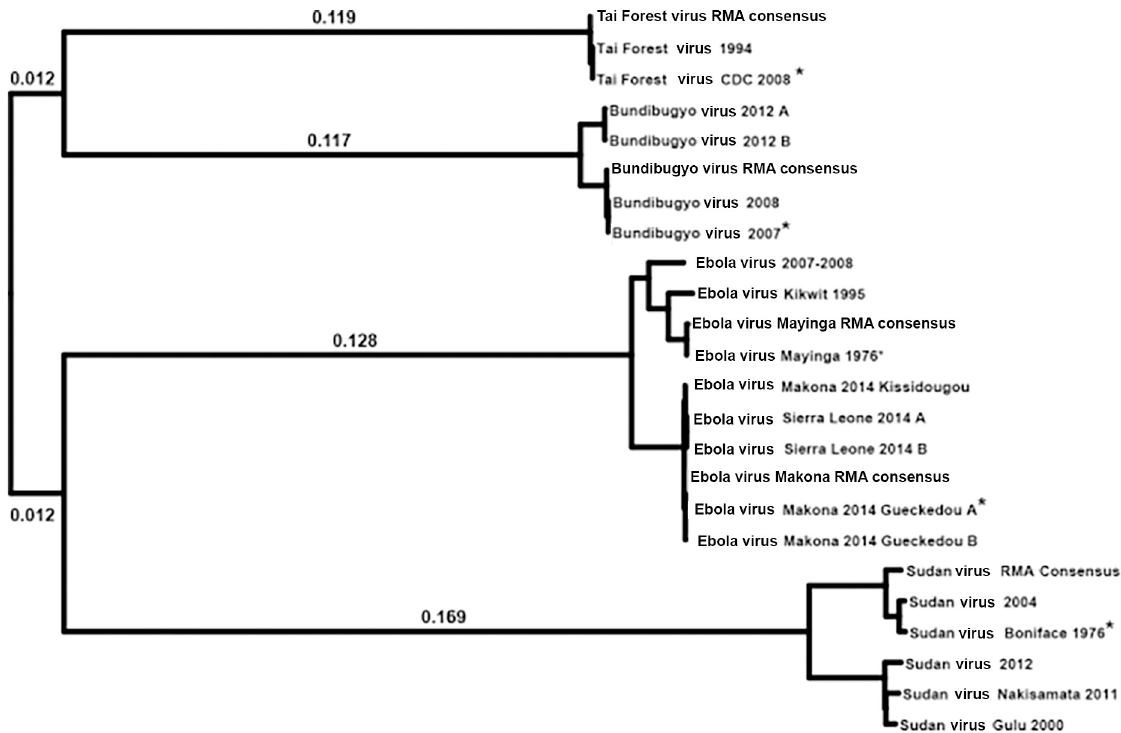
Fig 3. Phylogenetic tree alignments. A phylogenetic tree of Ebolavirus-RMA results for five repository RNA samples consensus sequence results (three replicates for each sample) aligned to representative database entries for five Ebolaviruses/variants. Alignments are done with MUSCLE software using default parameters in MacVector version 17.0 with the bootstrap method. The asterisks ( * ) denote the database sequence file for the repository Ebolavirus RNA samples that were processed by the Ebolavirus-RMA. Numbers on the branches are distances in phylogenetic units.